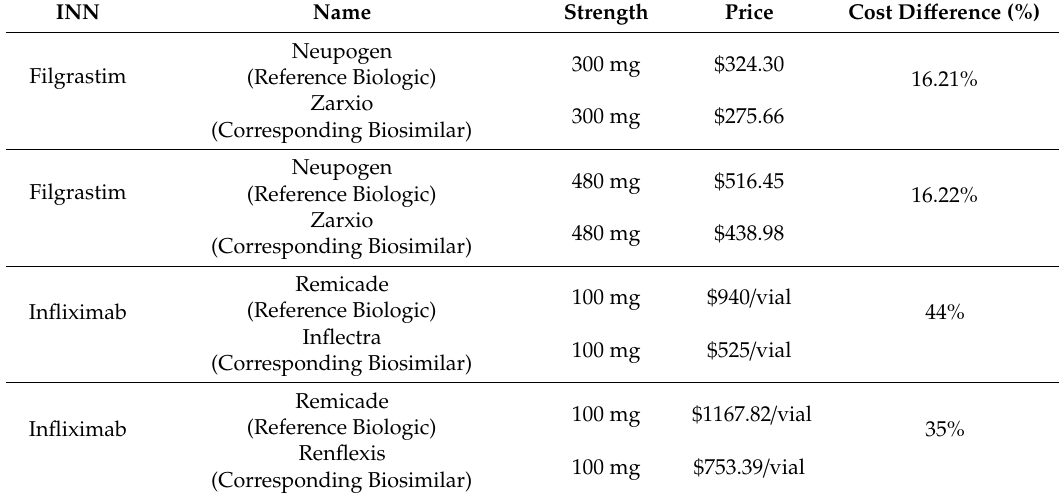
Table 4. Percentage cost comparison of a few biosimilars and their reference